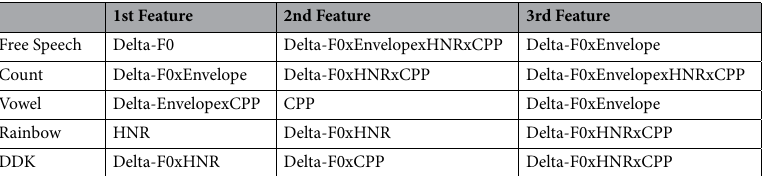
Table 1. Top correlation-based features. Top 3 performing features in each task in creating GMM models using correlation-based features. The top 3 features were selected by comparing the performance of the models trained and tested on the recordings from the first